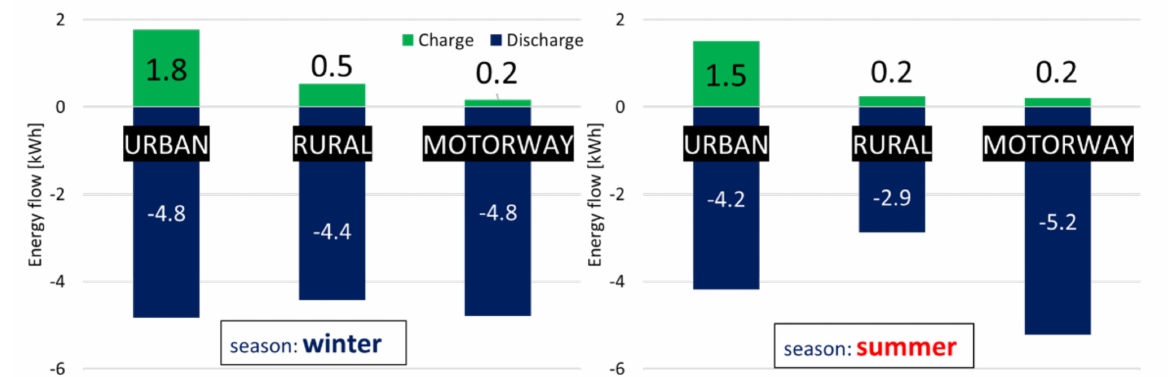
Figure 12. Energy consumption balance in terms of road and weather conditions.